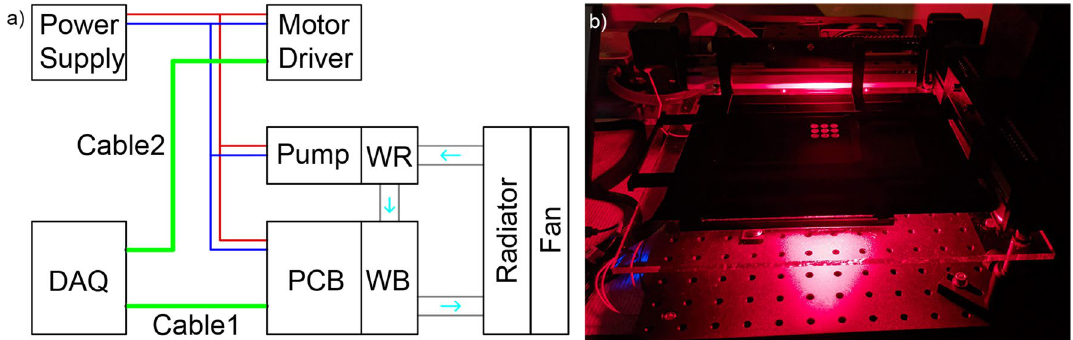
Figure 5. ( a ) The electrical wiring diagram of the system. DAQ, data acquisition board; PCB, LED array printed circuit board; WB, water block; WR, water reservoir. Cable1: 4-wire analog cable consisting of PWM control, thermistor signal, ground, and phototransistor signal. Cable2: 3-wire digital cable consisting of stepper motor pulse control, direction control, and ground. Note the other motor driver and its control cable (same as Cable2) is not shown to simplify the diagram. The cyan arrows indicate the water flow direction. ( b ) The LED array system in operation during a 96-well plate PDT experiment. Note the opaque cover above the plate is removed to show the illuminated 3 × 3 wells in this